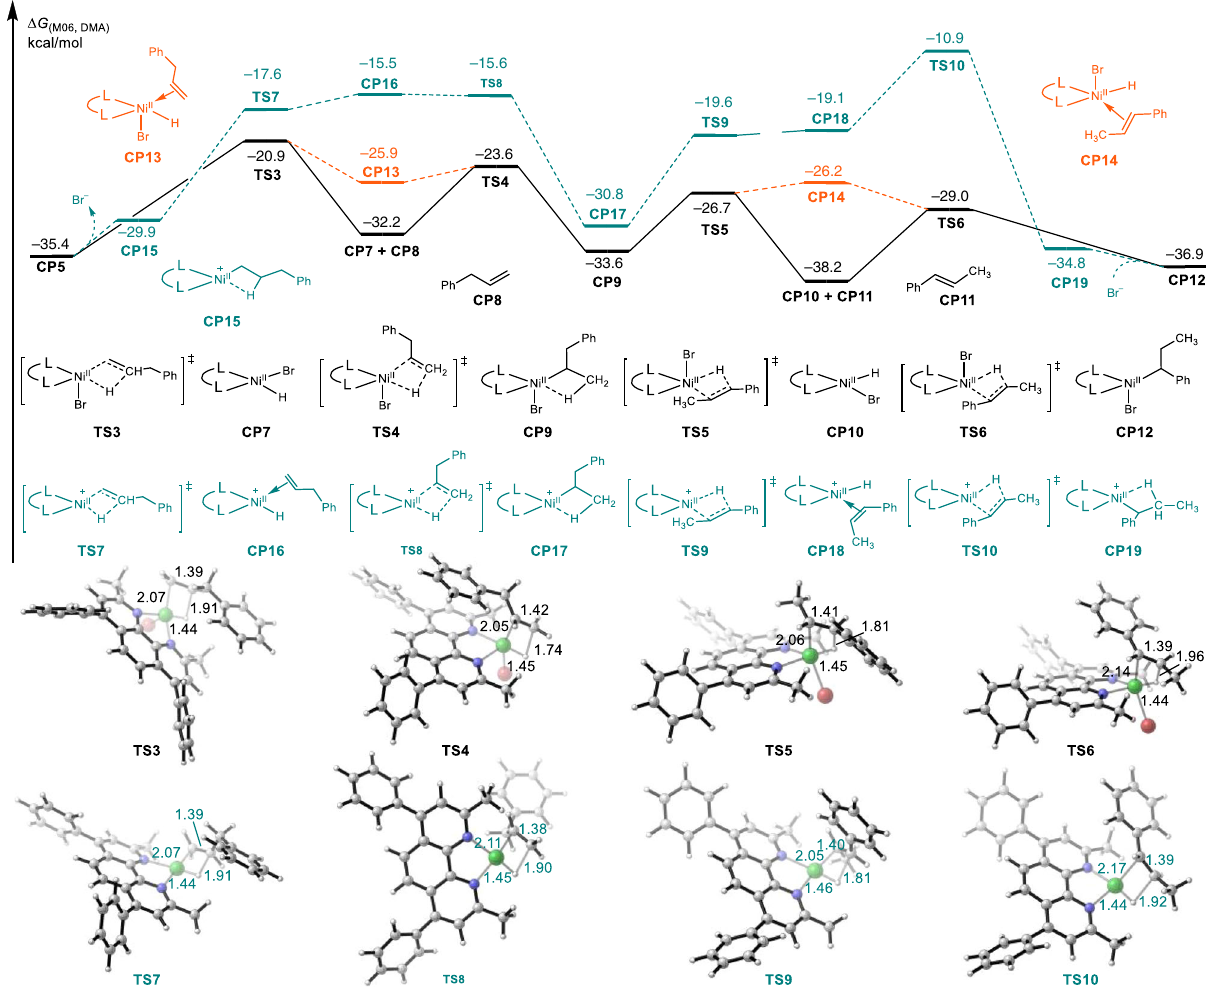
Fig. 7 The calculated reaction energy pro fi le of nickel chain-walking process. Energy values are given in kcal/mol and represent the relative free energies calculated by the M06 method in N , N